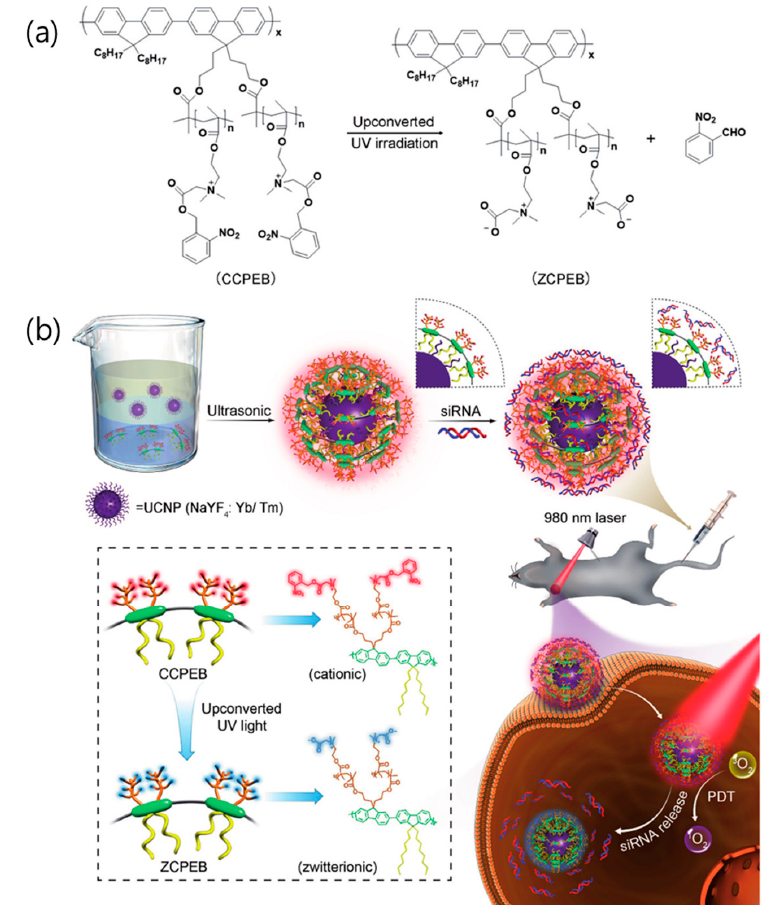
Figure 4. ( a ) Photoinduced charge-variable cationic conjugated polyelectrolyte brush (CCPEB). ( b )